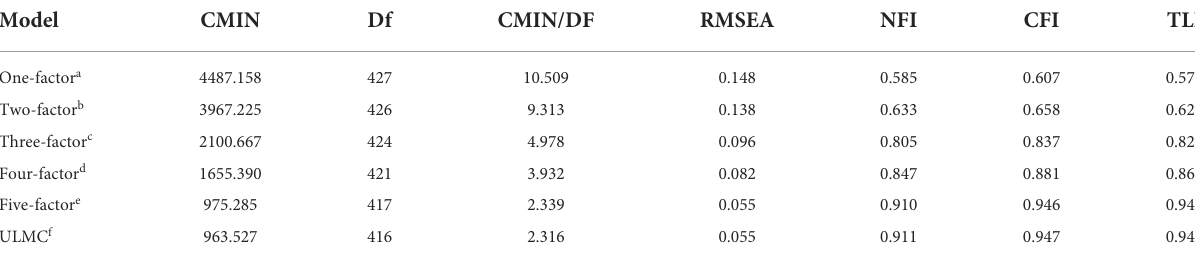
TABLE 2 Result of CFA.